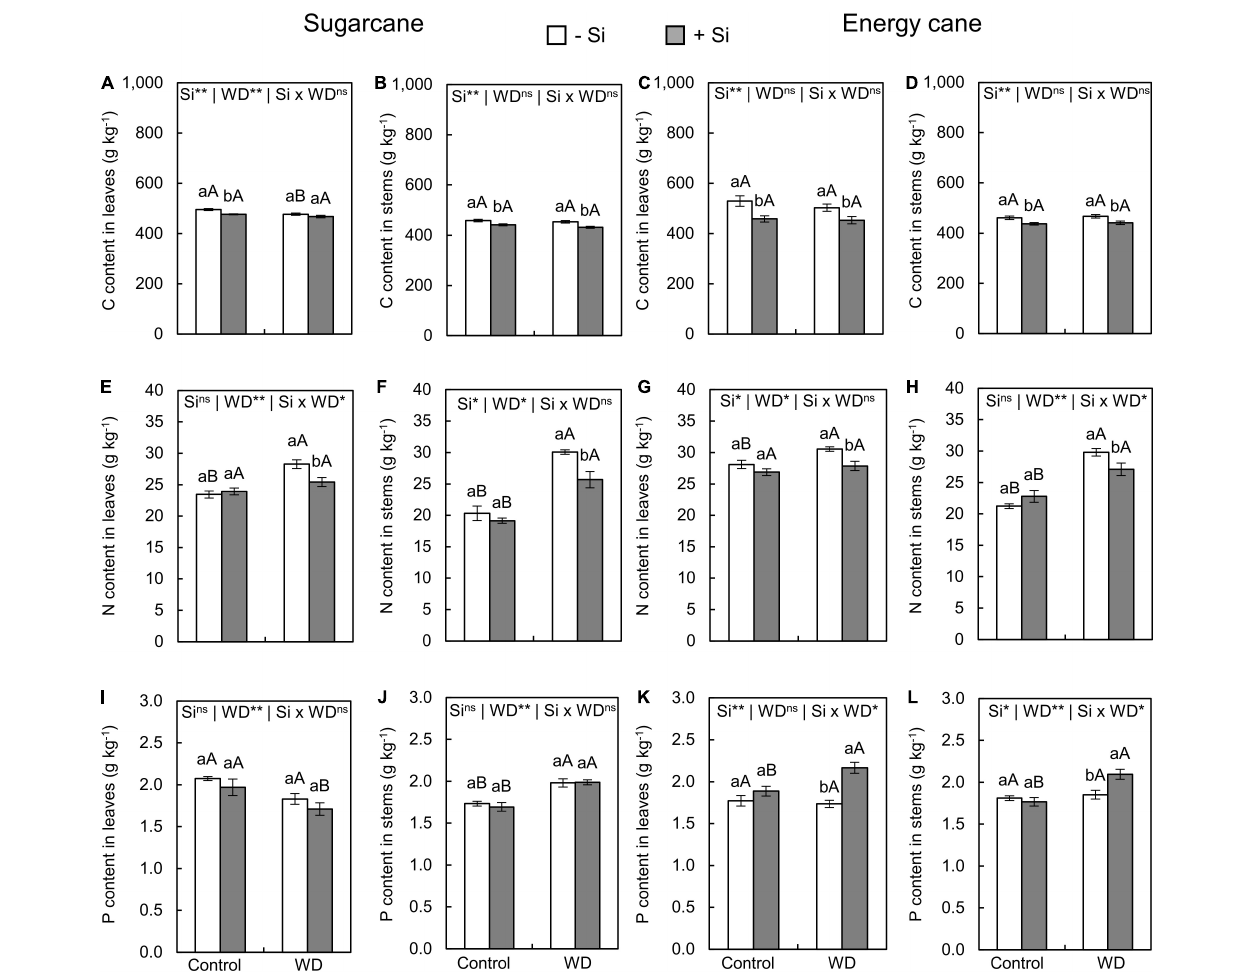
FIGURE 3 | Contents of carbon (C), nitrogen (N), and phosphorus (P) in the leaves and stems of sugarcane (A,B,E,F,I,J) and energy cane (C,D,G,H,K,L) in -Si, and + Si under adequate water regime (control) and in WD for a period of 7 to 60 days after transplanting. ** and * significant with 1 and 5% probability, respectively, and ns, not significant by the F -test. Lowercase letters indicate differences in relation to Si and capital letters in relation to water deficit. n = 6. Si × WD: